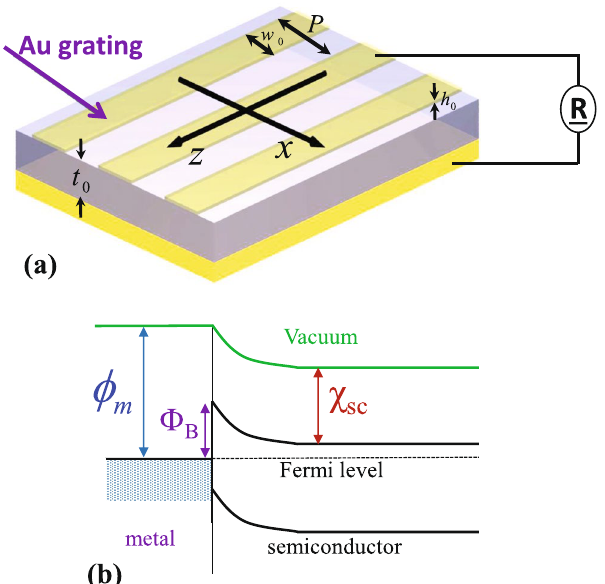
Figure 1. ( a ) Sketch of the proposed structure of a Schottky-based solar-cell. It is made of an active semiconductor layer sandwiched between two noble metals connected to an external load R . The geometrical parameters of the proposed structure are: width of the grating w the Silicon layer t . ( b ) Band diagram for the structure described in ( a ) across the junction, showing the 0 Schottky barrier and the different other parameters of the